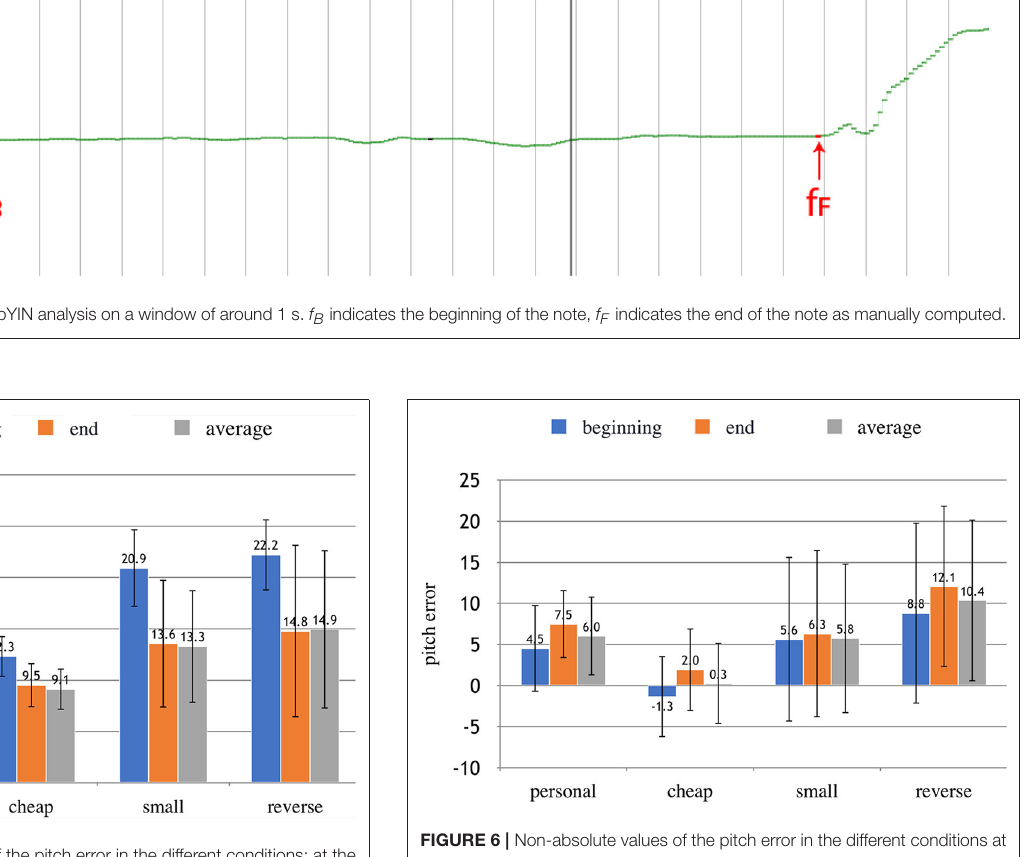
FIGURE 5 | Absolute values of the pitch error in the different conditions: at the beginning and at the end of each note, and their average value. The error bars show the StD. A high value indicates a high pitch error, thus a bad accuracy.